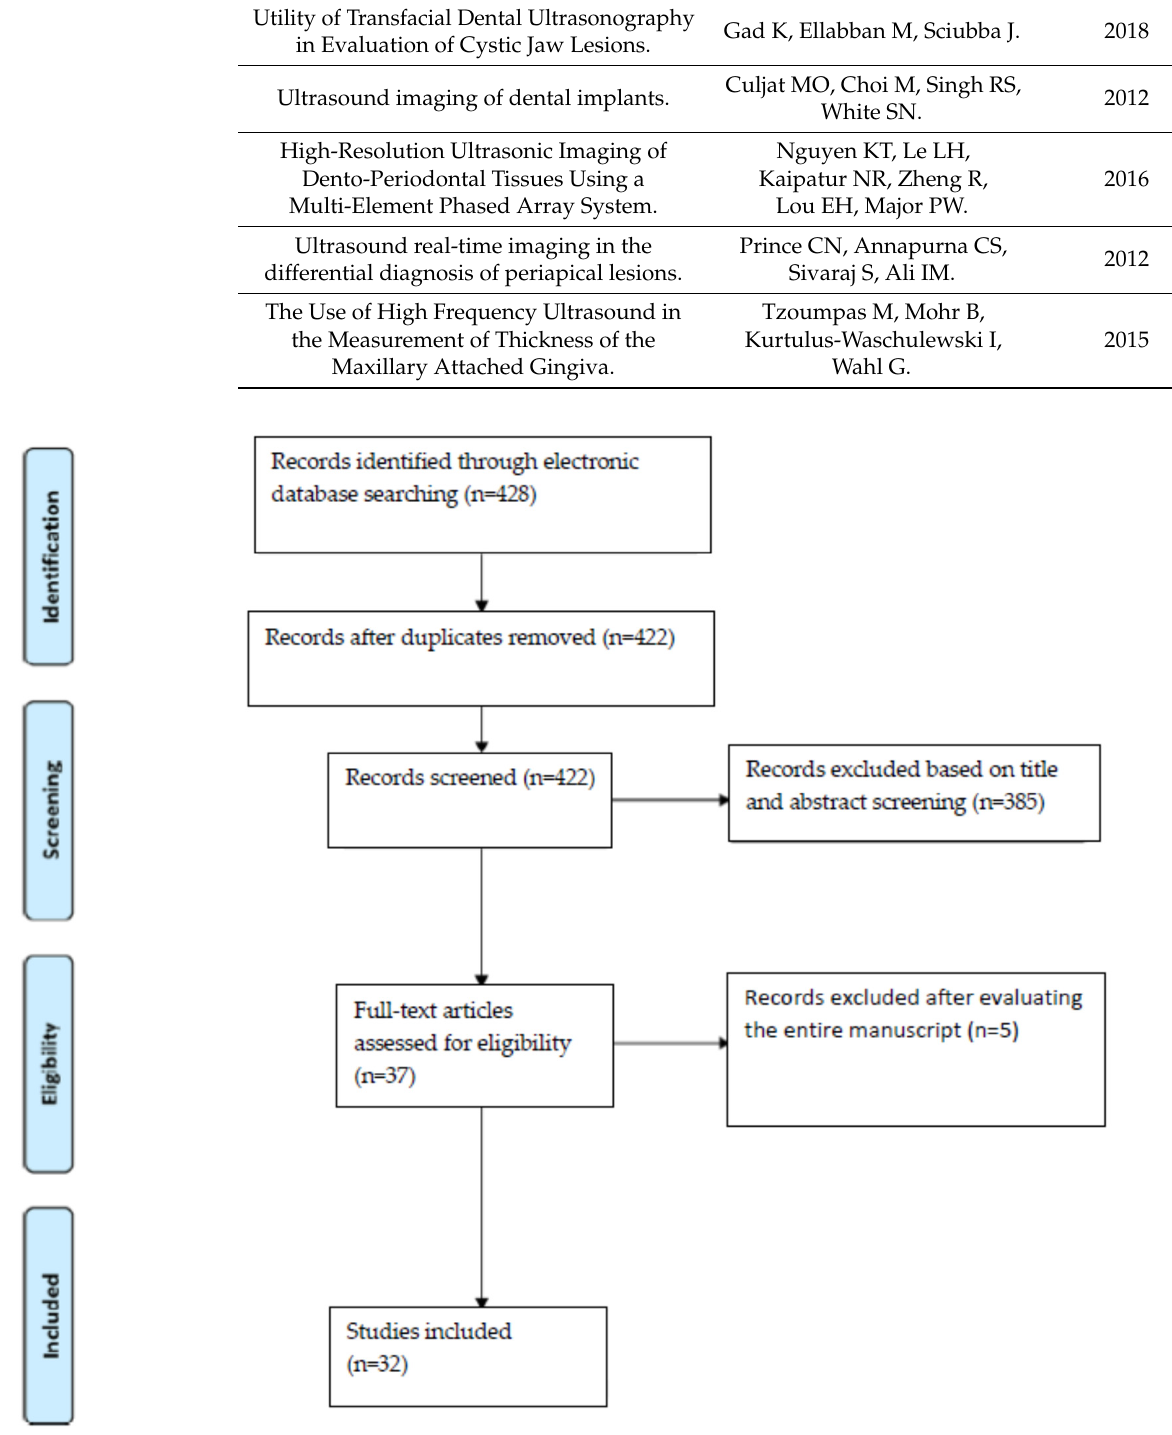
Figure 1. Search flow performed according to the PRISMA statement (Preferred Reporting Items for Systematic Reviews and Meta-Analyses) [14].